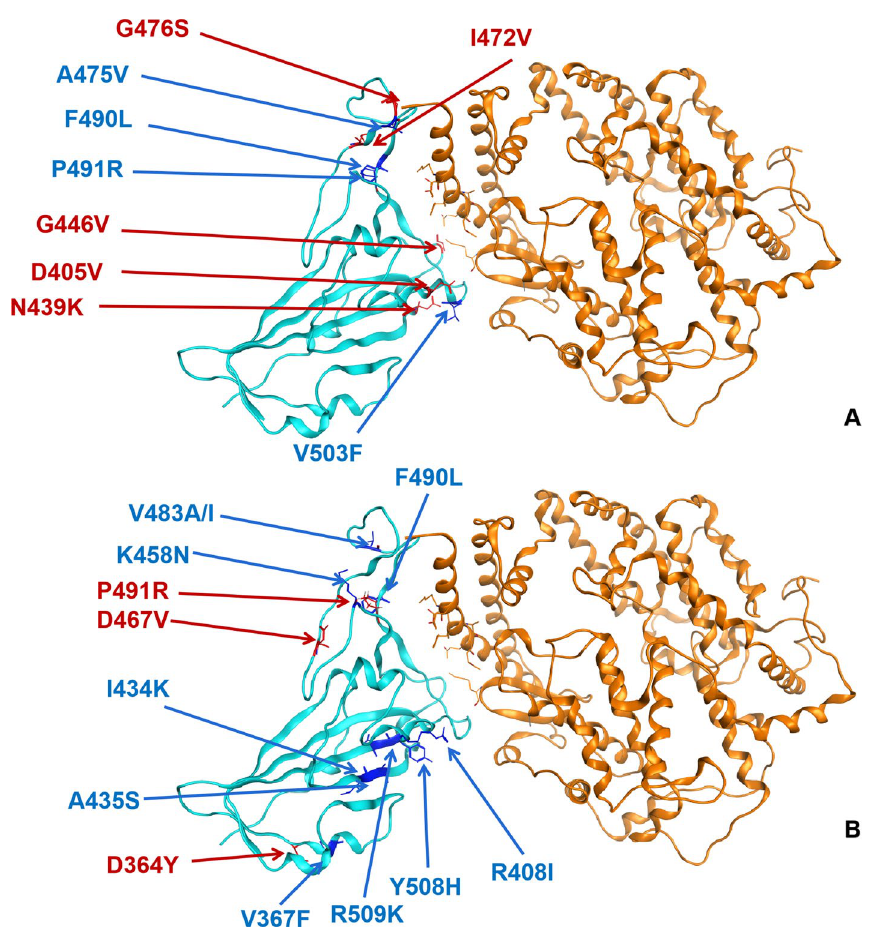
Figure 5. Reported variants in spike protein RBD mapped to the structure of spike protein in SARS-CoV-2 in complex with ACE2 in humans. Blue = spike protein, Orange = ACE2, dark blue presents decreasing affinity and stability while red presents increasing ones. ( A ) Affinity; ( B ) Stability.